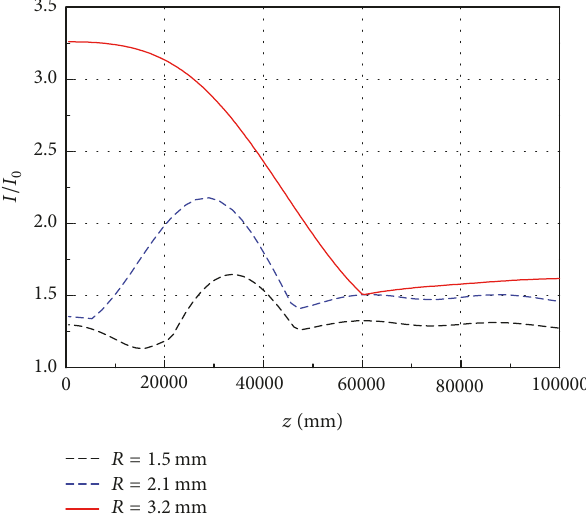
Figure 5: Intensification factor varying with distance from image relay plane.